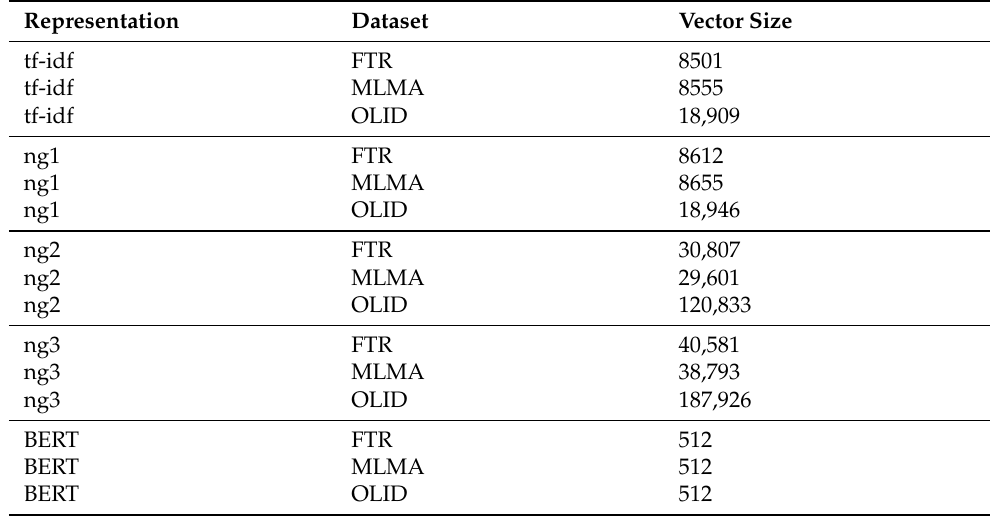
Table 5. Sizes of tf-idf and n-gram vector